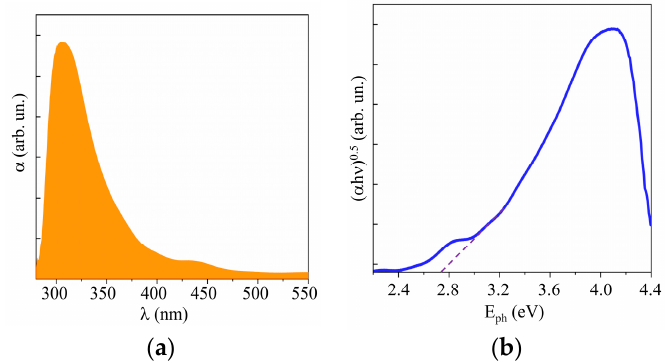
Figure 5. ( a ) UV–visible absorption spectra and ( b ) Tauc plot of a WO 3 film obtained on FTO substrate by RPLD at a dry air pressure of 40 Pa.